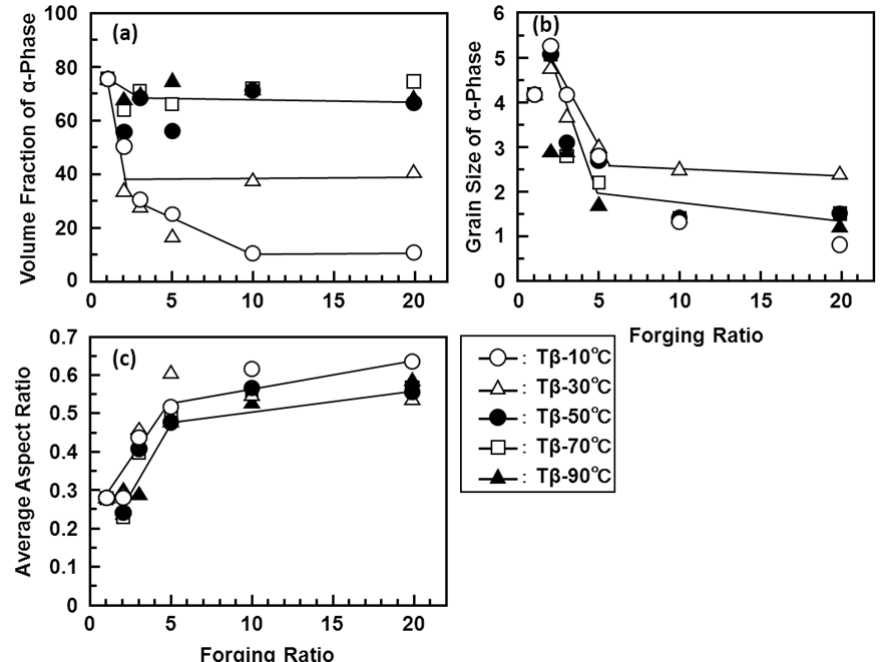
Figure 9. ( a ) Effects of forging ratio and forging temperature on volume fraction of α -phase; ( b ) grain size of α -phase; ( c ) and average aspect ratio of α